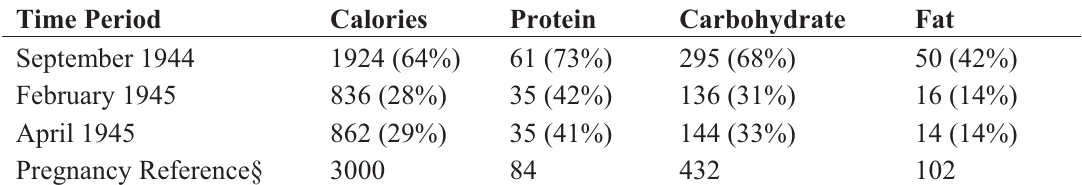
Table 3. The Dutch Famine daily food rations by week and pregnancy trimester periods July 1944 to July